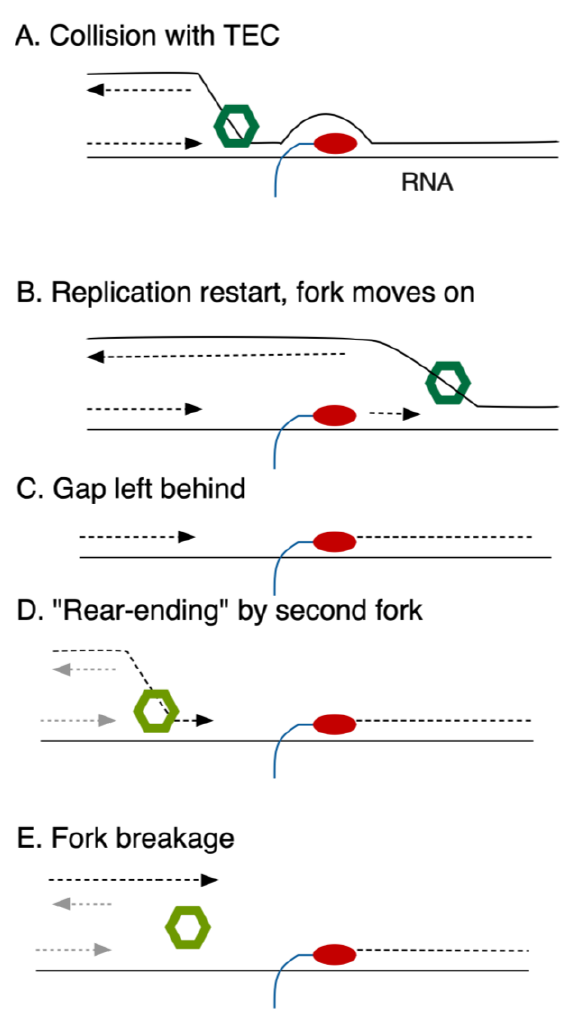
FIGURE 1: Events leading to fork breakage after collision of DNA pol III with transcription elongation complexes (TEC). Dia- grammed are events ensuing from codirectional collisions, but can occur similarly with head-on collisions. RNAP is illustrated in red, the fork helicase in green. (A) The fork encounters a TEC, that blocks DNA polymerization. (B) The fork moves on, replica- tion is restarted. (C) A single-strand gap is left behind. (D) Con- vergence of a second fork (helicase marked with lt green) onto the gap. (E) The resulting one-ended double-strand